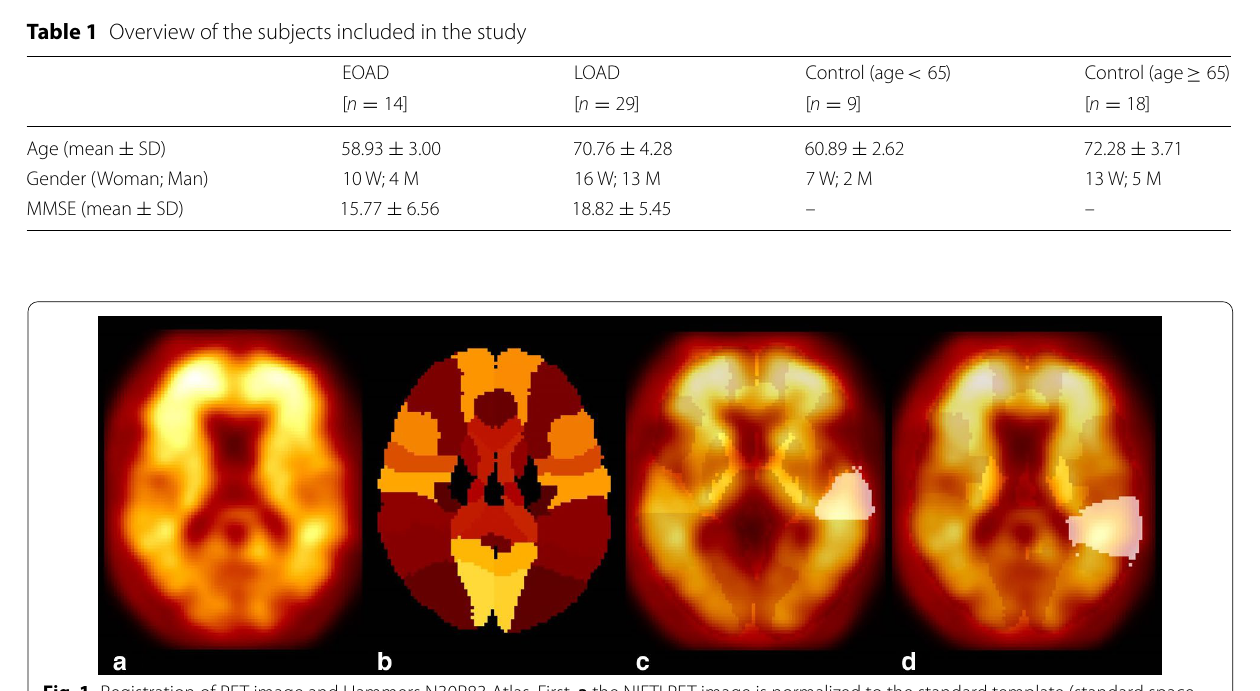
Fig. 1 Registration of PET image and Hammers N30R83 Atlas. First, a the NIFTI PET image is normalized to the standard template (standard space composed of 91 × 109 × 91 voxels with a resolution of 2 × 2 × 2 mm 3 ). Second, b the Hammers N30R83 Atlas is normalized to the standard template space. Third, the VOIs are further extracted. As an example, the superior temporal gyrus c and the parietal gyrus d are